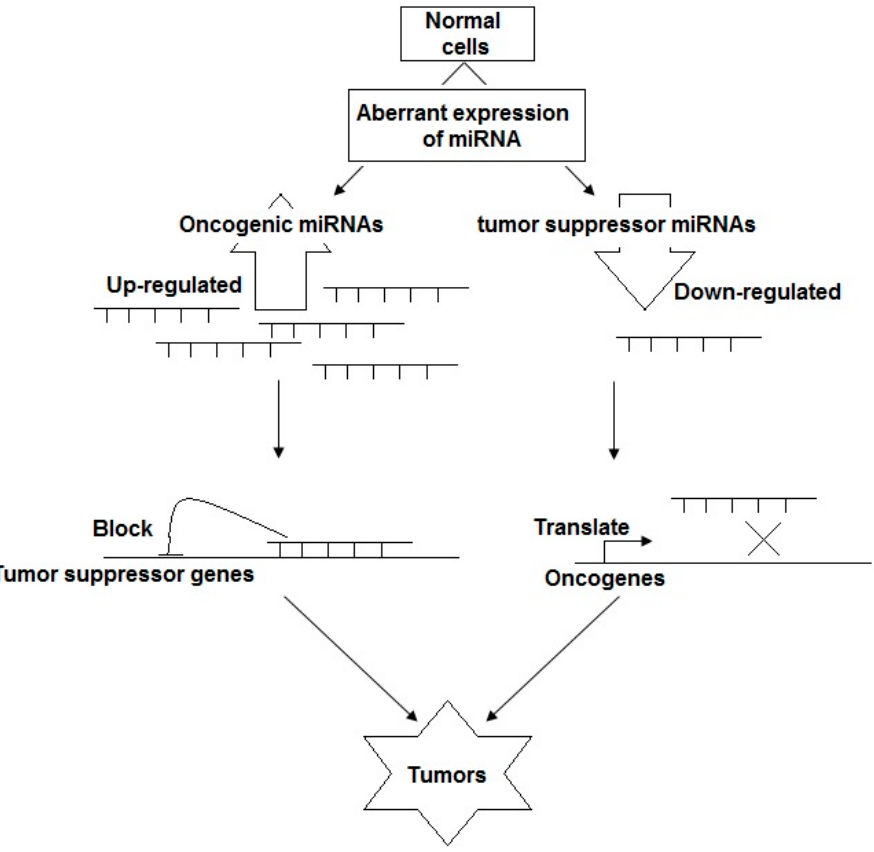
Figure 4. The biological function of miRNAs: tumor suppressors or oncogenic miRNAs.